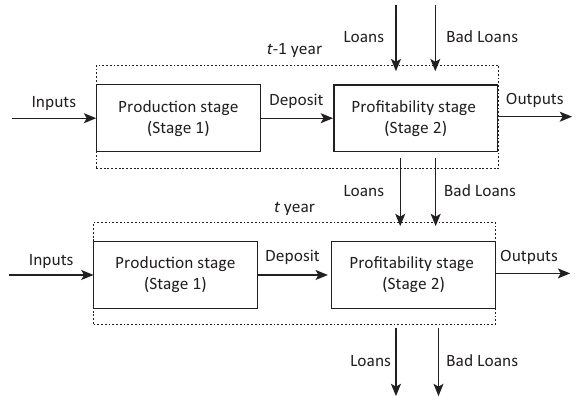
FIGURE 1: The dynamic network structure of banking technology in period